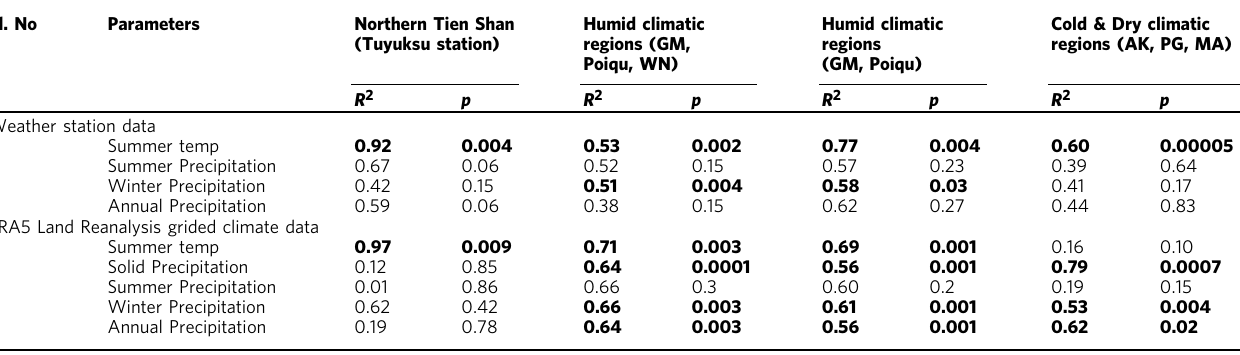
Table 1 Correlation between different meteorological variables extracted from weather station observations, ERA5 Land and glacier mass balance estimates for different regions and climatic